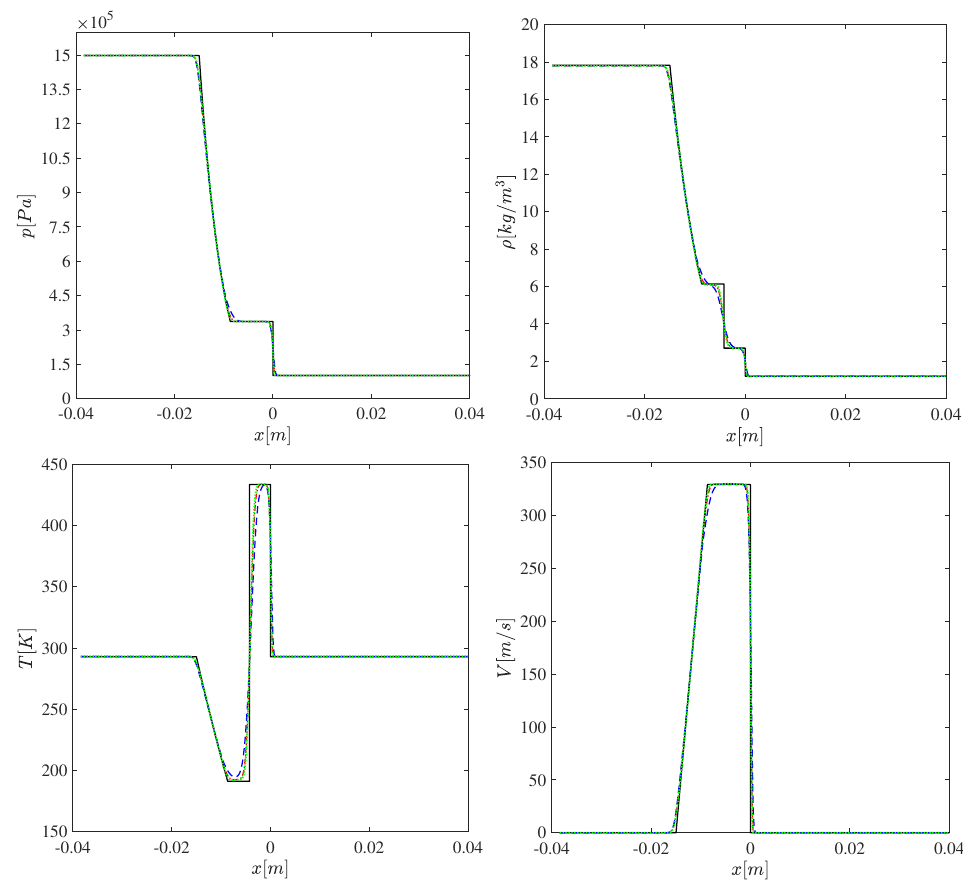
Figure 2. Shock tube flow: profiles of pressure ( top left ), density ( top right ), temperature ( bottom left ), and streamwise velocity ( bottom right ) at the impact time instant. Solutions with varying resolution, CFD I (blue dashed line), CFD II (red dashed-dotted line), and CFD III (green dotted line), compared to the exact solution (black solid line).